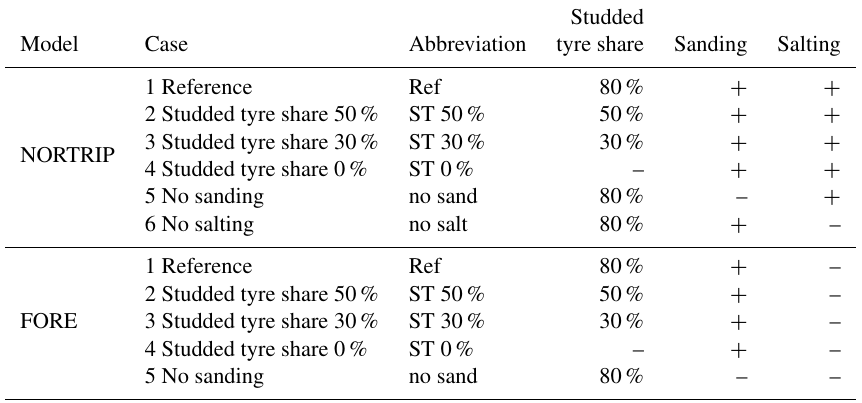
Table 6. The selected numerical cases with maximal shares of light-duty vehicles using studded tyres and road maintenance measures for traction control considered by the two road dust emission models. The symbol + refers to “included” and – to “not included”. Studded Model Case Abbreviation tyre share Sanding Salting